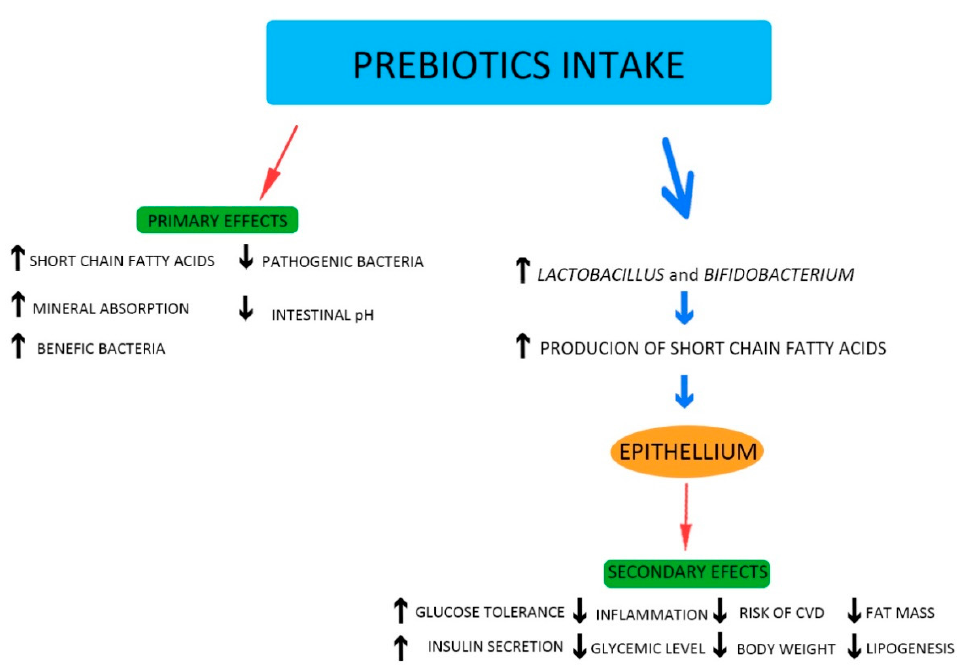
Figure 1. Positive effects of